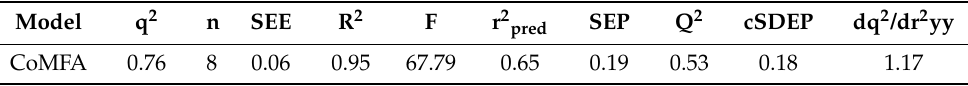
Table 1. Evaluation parameters of the combined activity